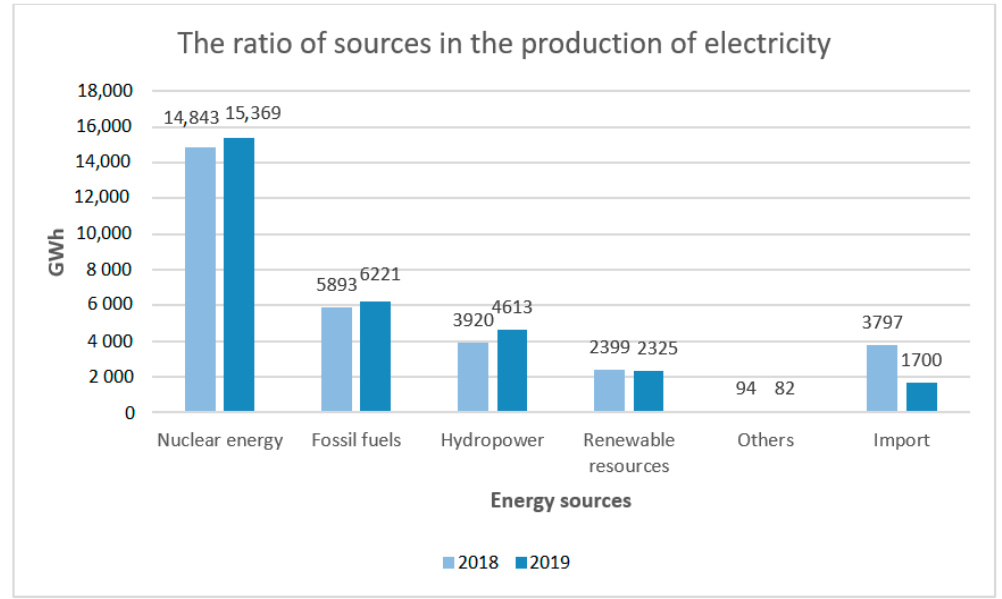
Figure 1. The ratio of energy sources in the production of electricity in Slovakia in 2018 and 2019 [3].